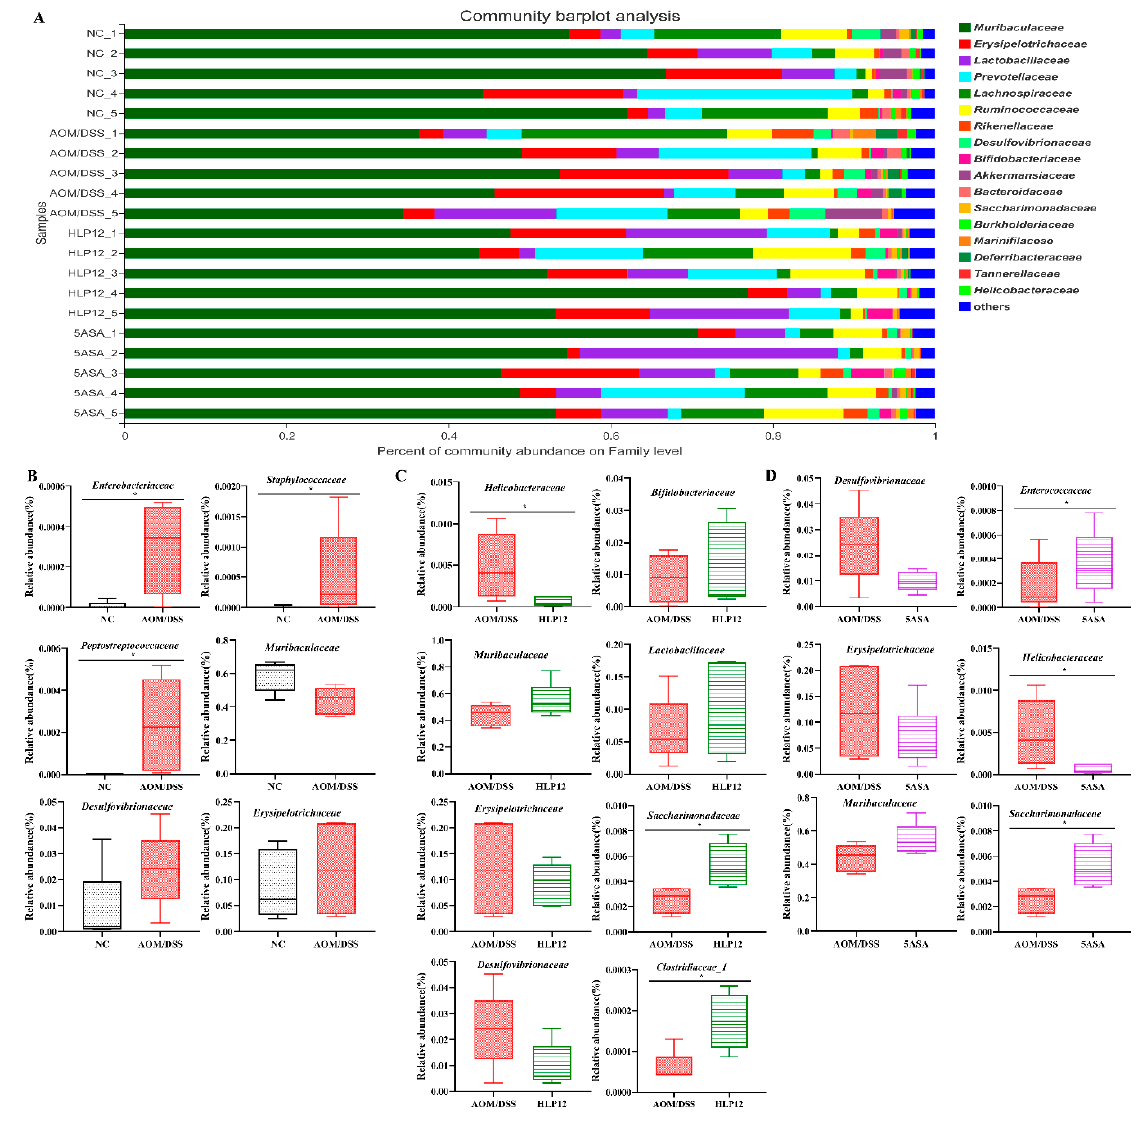
Figure 9. Effect of L. plantarum -12 oral administration on intestinal microbiota at the family level of AOM/DSS-treated mice ( n = 5). ( A ) Bar picture, ( B ) NC vs. AOM/DSS species difference analysis, ( C ) AOM/DSS vs. HLP12 species difference analysis, and ( D ) AOM/DSS vs. 5ASA species difference analysis. * p < 0.05.